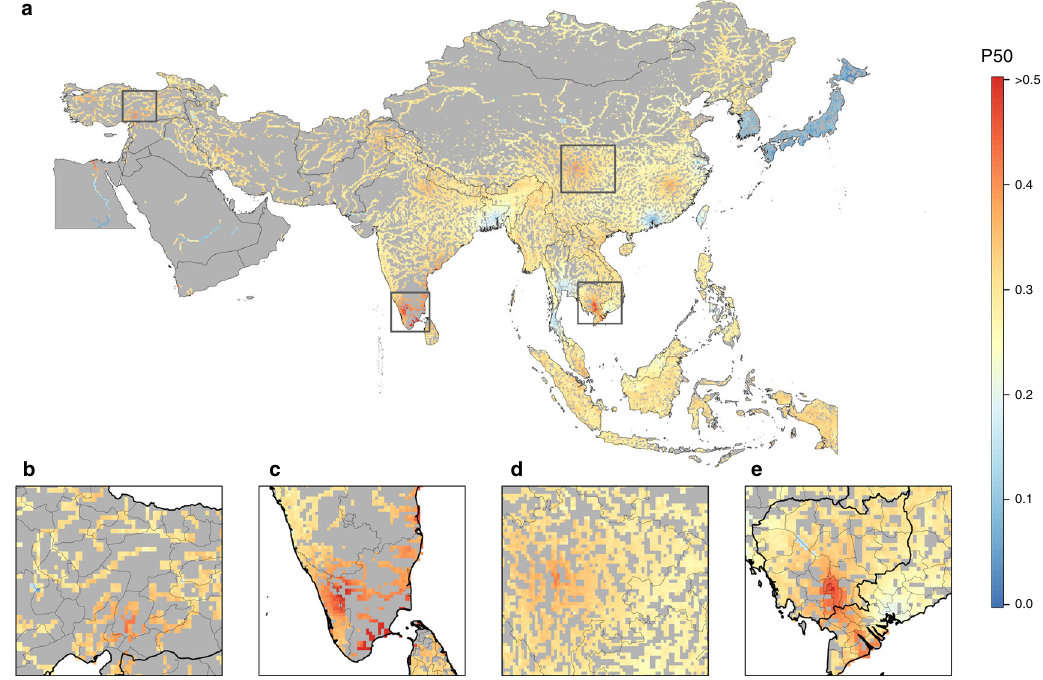
Fig. 3 Geographic distribution of antimicrobial resistance in freshwater environments in Asia. The proportion of antimicrobial compounds in each survey with resistance higher than 50% (P50) at continental scale ( a ); eastern Turkey ( b ); southern India ( c ); Yangtze River drainage basin in China ( d ); and the Mekong River delta ( e